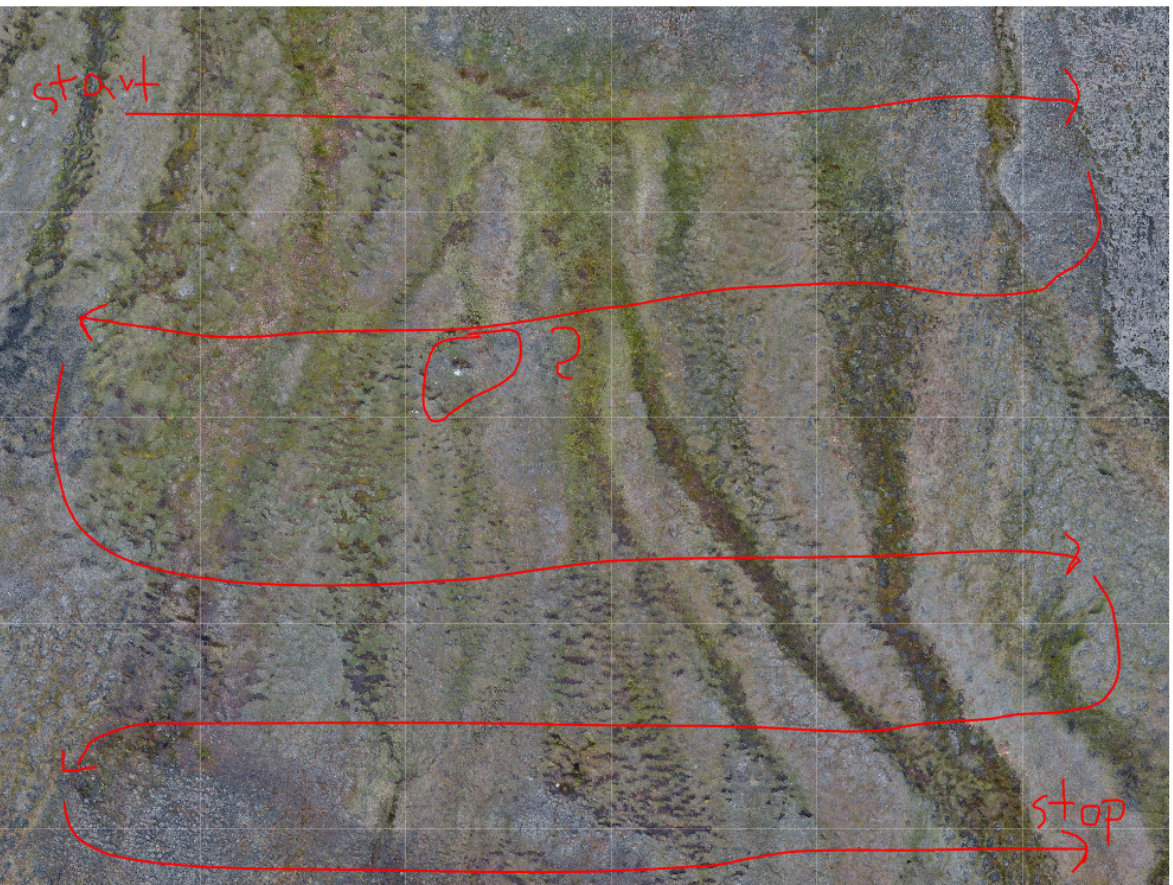
Figure A6. Example of how to scan an image.